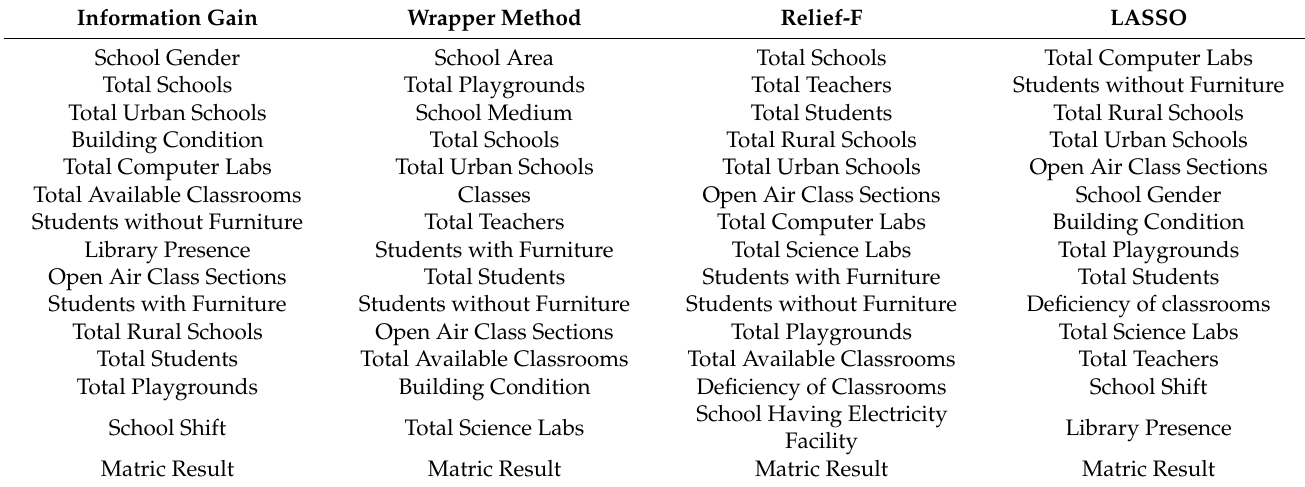
Table 2. Significant feature selection through feature selection